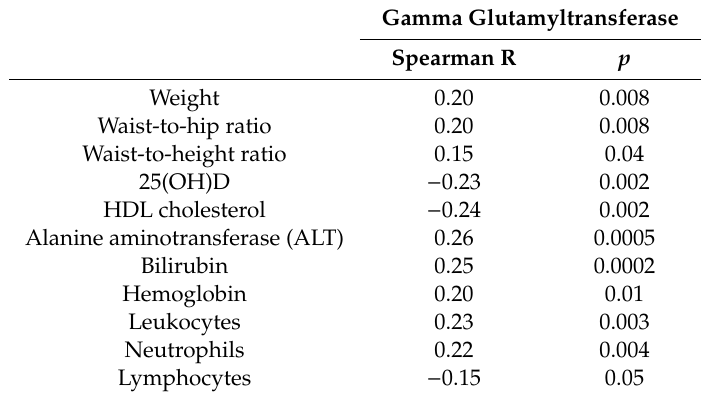
Table 3. Correlations between gamma glutamyltranferase and clinical features and laboratory